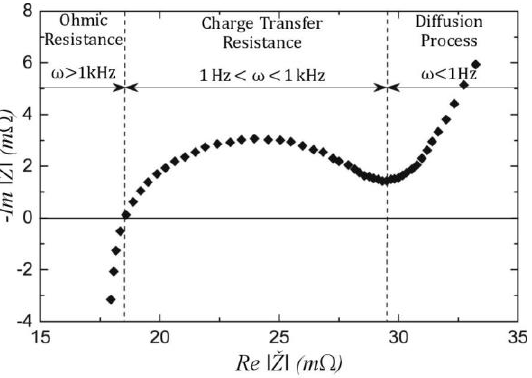
Figure 1. EIS impedance spectrum of a Li-ion cell (reproduced from ref [28]). Electrical (ohmic) resistance is obtained at the intersection of the real to the imaginary axis, whereas the semicircle is associated with the SEI, the double-layer capacitance, and the charge transfer resistance. In this case, the SEI has a larger impact, another semicircle will be created at higher frequencies, which represents the SEI. At the lowest frequencies, usually below 1 mHz, the concentration resistance can be obtained due to the diffusion in the liquid and the solids. The general form to obtain the impedance at any frequency is: